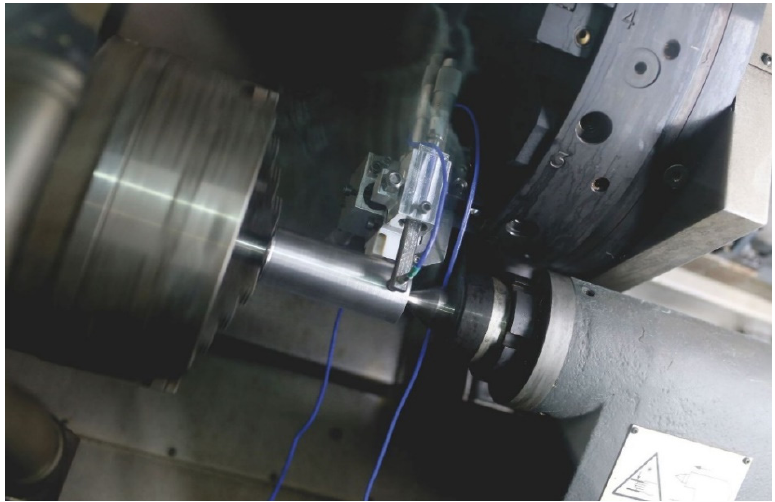
Figure 1. View of the measuring head mounted on the DMG Alpha 500 machining centre.